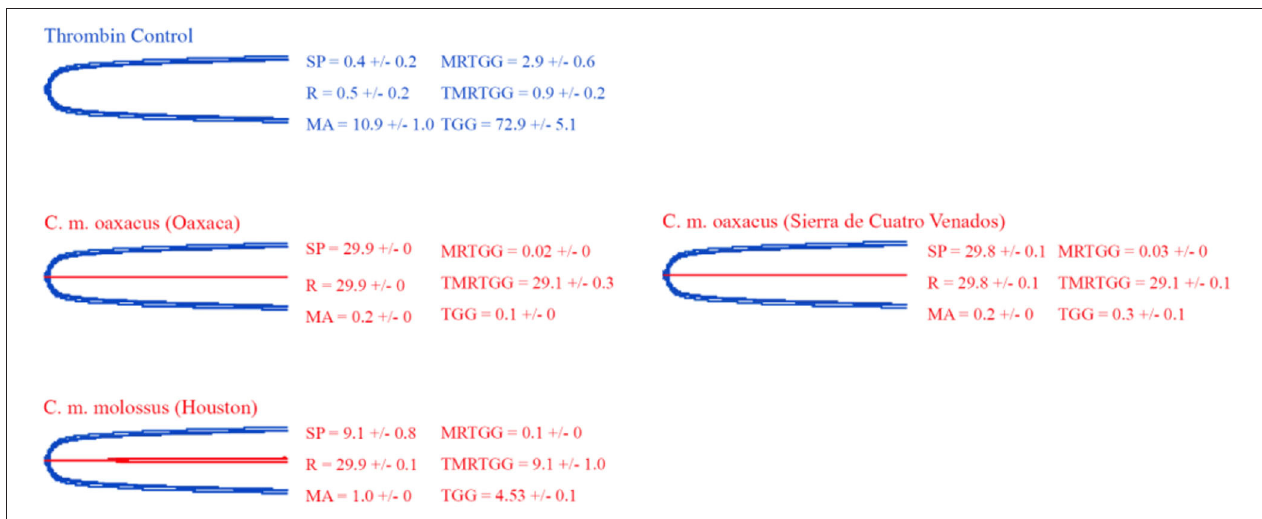
the Australian elapid genera Oxyuranus and Pseudonaja (58,